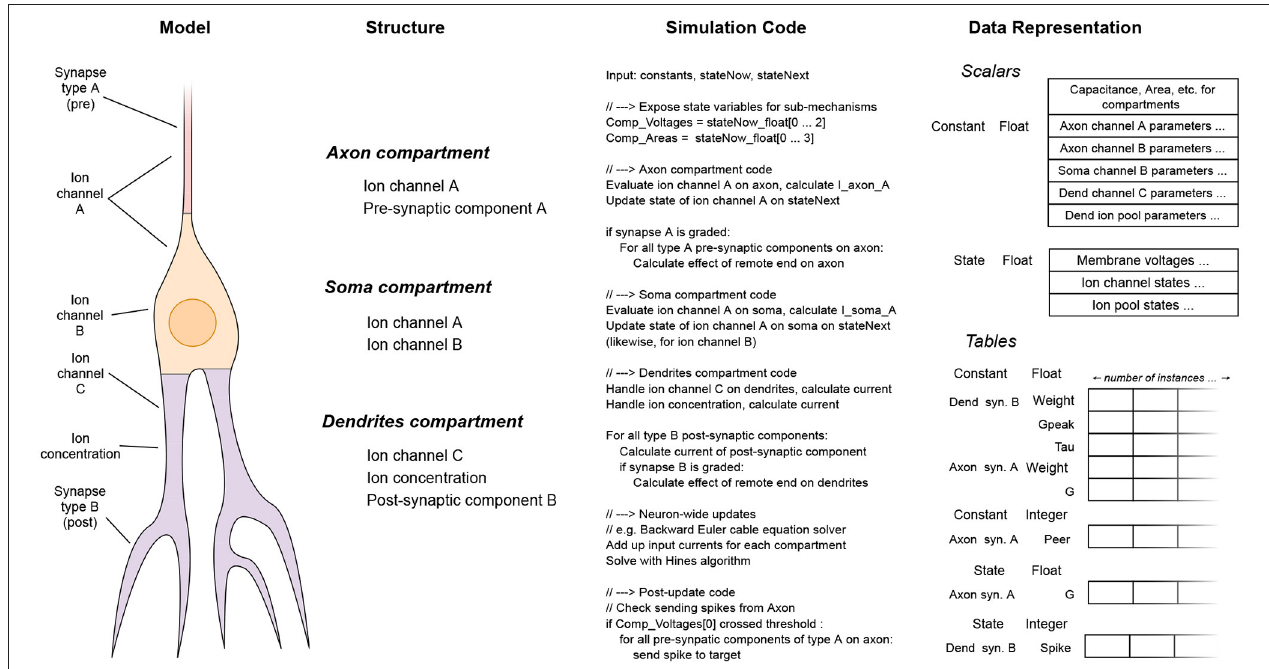
FIGURE 4 | The stages of the per-neuron signature synthesis process, for neurons with few (phenomenological) compartments. The neuron shown consists of three different compartments, each containing different physiological mechanisms. The simulation code for all mechanisms is laid out in a flat format, along with their associated data. Thus, a streamlined and compact code kernel is created for this specific type of